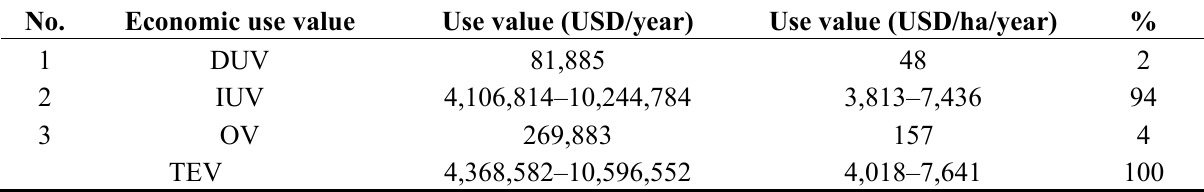
Table 4. The Total Economic Value (TEV) of mangrove in the Takalar district, South Sulawesi, Indonesia.